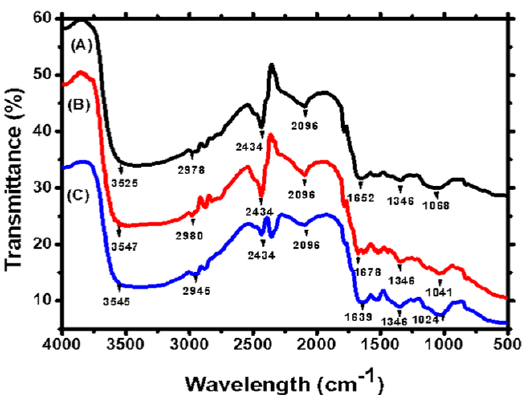
Figure 2. FTIR spectra of (A) non-treated and (B) Cd — and (C) Pb — treated dry